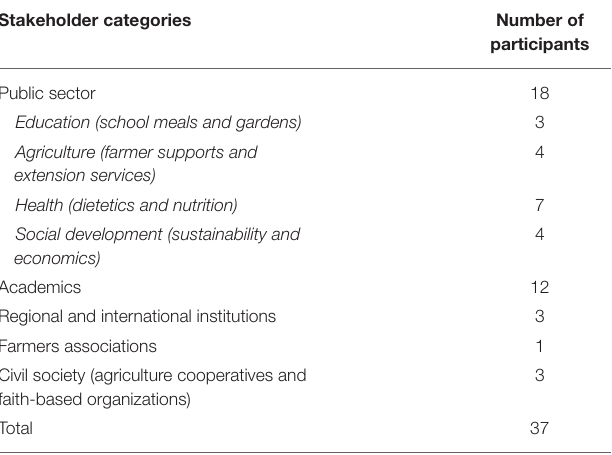
TABLE 1 | Categories of workshop stakeholders and number of participants in each category. Stakeholder